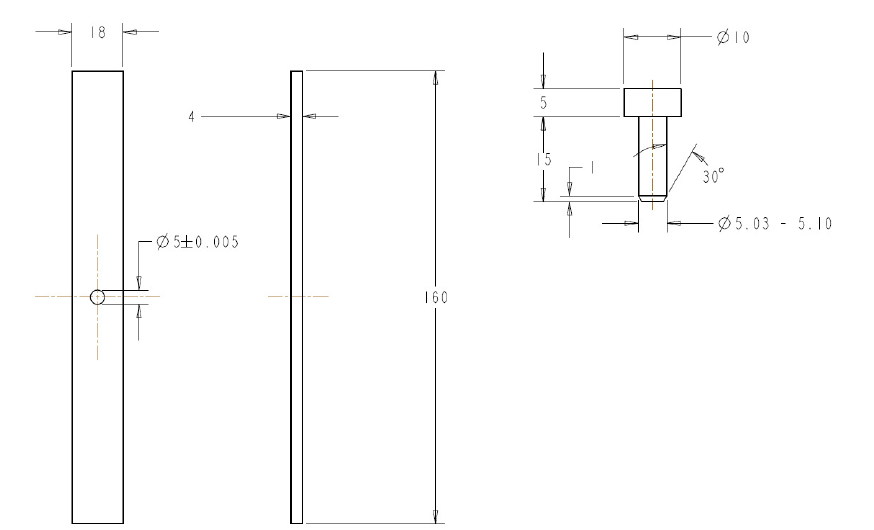
Figure 2: Specimen draft: K t =3.31.